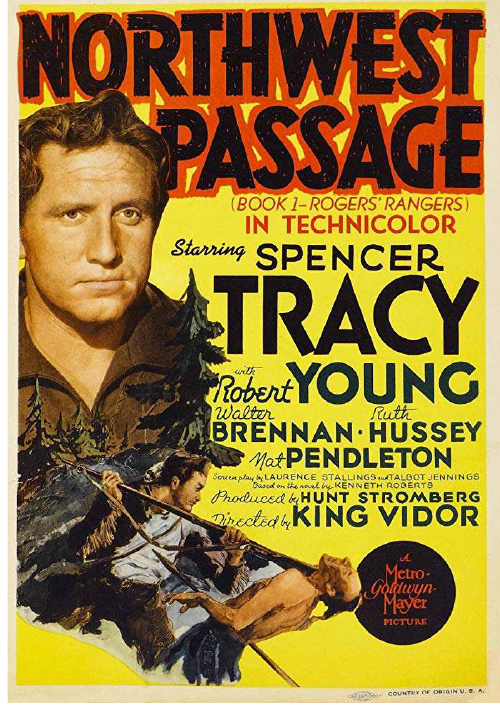
Figure 5. Movie poster for Northwest Passage (1940) by King